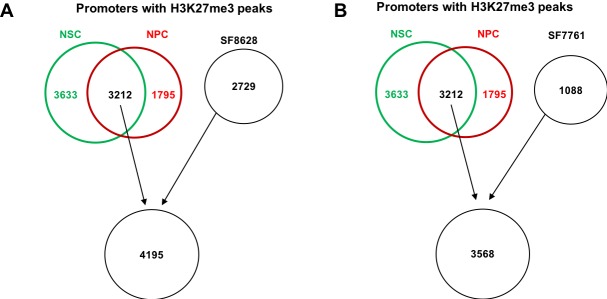
In silico identification of H3K27me3 peaks at tumor-initiating cells of SF8628 and SF7761.The diagram shows how gene promoters with H3K27me3 were identified in tumor-initiating cells of SF8628 (A) and SF7761 (B). Based on the average level of H3K27me3 at these gene promoters, gene promoters were separated into two groups, those with high levels of H3K27me3 and those with low levels of H3K27me3 in each cell line. The enrichment of H3K27me3 and H3.3K27M mutant proteins in each H3.3K27M mutant line at these two group of gene promoters was calculated as shown in Figure 3F–3I. The promoters with H3K27me3 ChIP-seq peaks overlapped in both control cells (NSC and NPC) were chosen to potentially increase the stringency of peak identification.